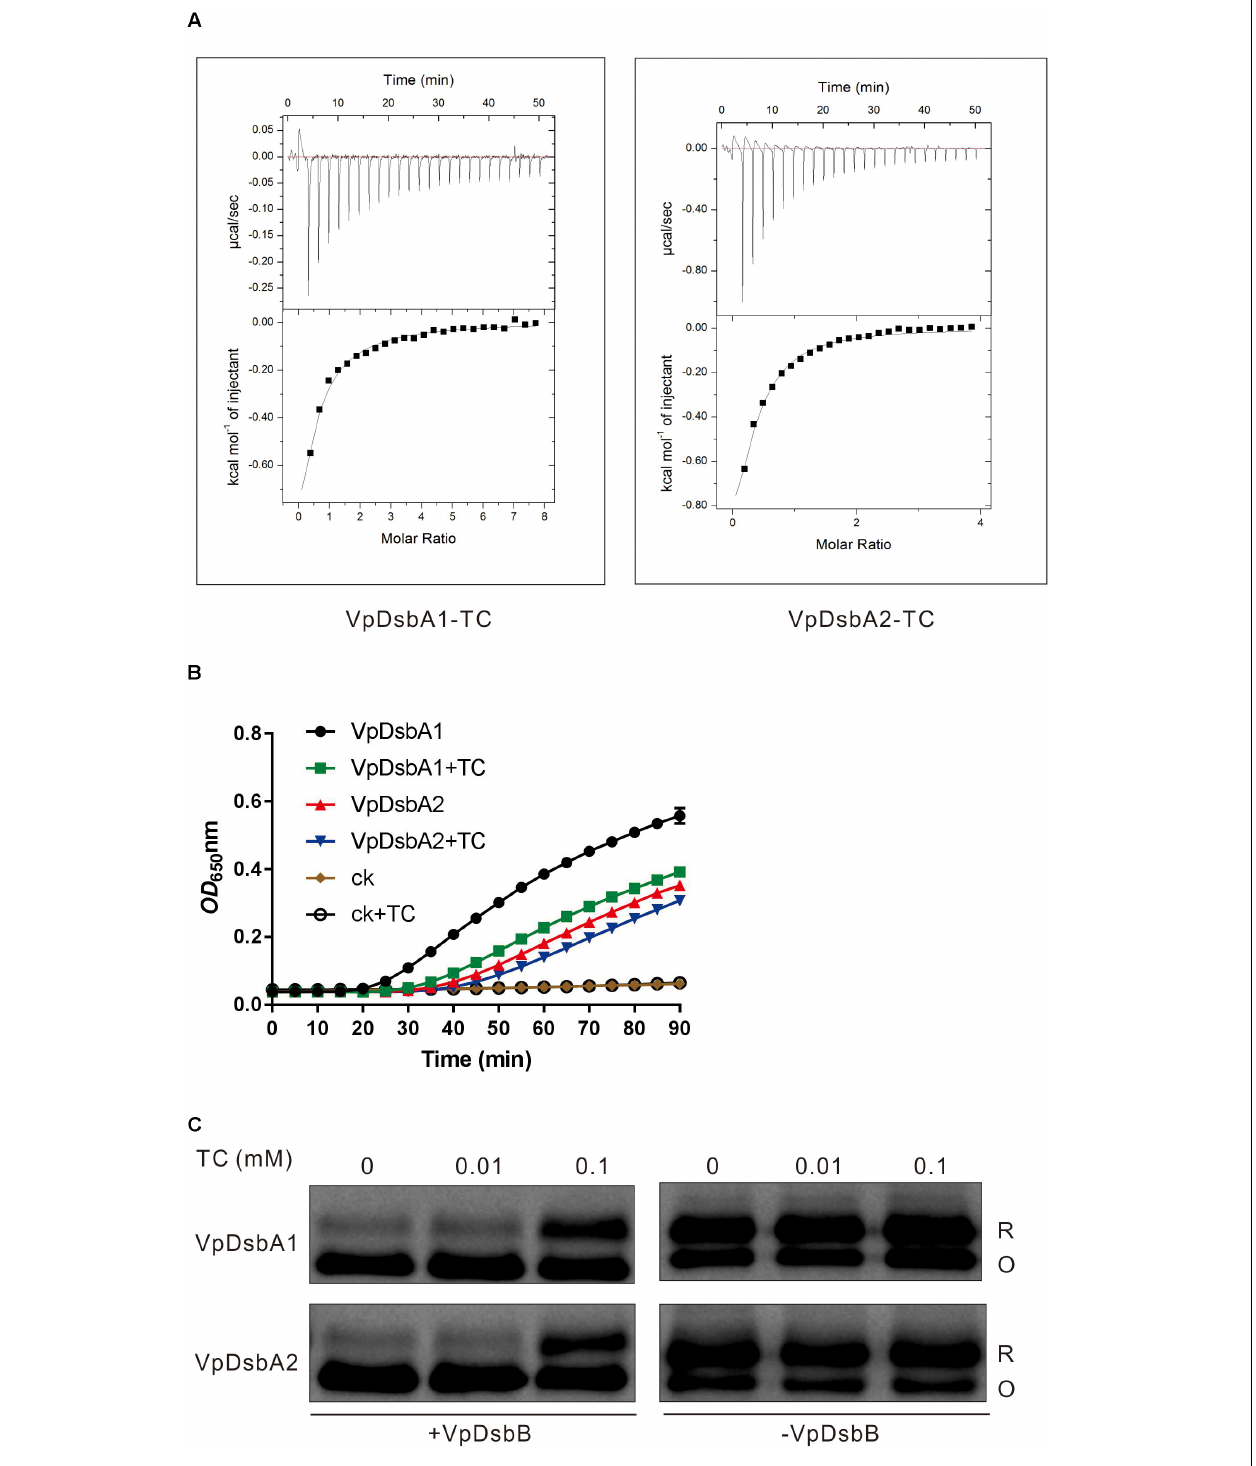
FIGURE 4 | Bile salts inhibit VpDsbAs activity. (A) Bile salts interact with VpDsbA. ITC data titrating 4 mM of TC into 0.2 mM of tested proteins, VpDsbA1 (left) and VcDsbA2 (right). (B) Insulin reduction by VpDsbA1 or VpDsbA2 was inhibited in the presence of TC. Insulin (170 µ M) and 0.33 mM DTT was incubated with 10 µ M of VpDsbA, and 0.1 mM of TC were added at the beginning of reaction. The reduction of insulin was measured by monitoring the increase in absorbance at OD 650 . (C) Reduced VpDsbA oxidized by VpDsbB present in the membranes in vitro . Reduced VpDsbA (2 µ M) was incubated with or without VpDsbB containing membranes and trapped with AMS after various incubation times. After incubation with VpDsbB membrane, VpDsbA (O) shifts to a lower molecular weight band. VpDsbA was detected using Western blot with an anti-VpDsbA antibody.